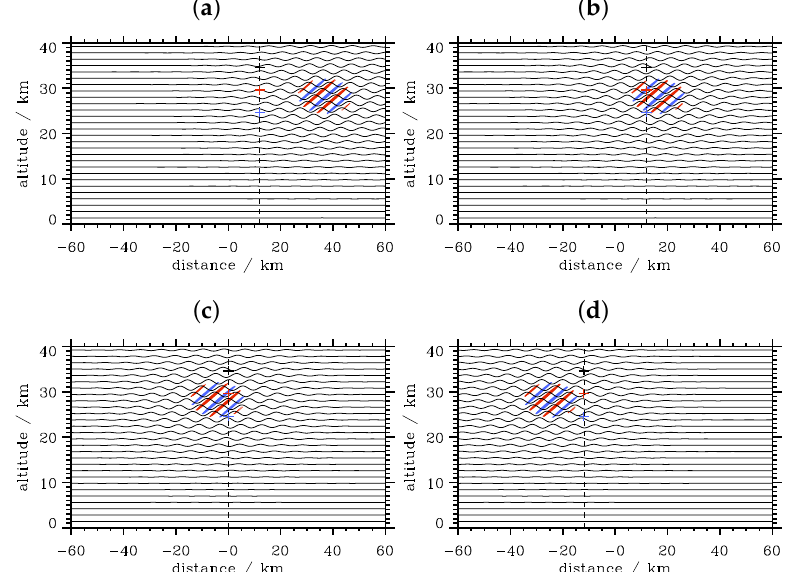
Figure 7. Spatial snapshots of the vertical displacements ξ ( x , z , t ) of horizontally- and vertically-propagating wave packets with wavenumber vectors (cid:126) k D at t = 60min. The wave frequencies are Doppler shifted by U = + c Px ( a ), U = 0 ( b ), U = − c Px ( c ) and U = − 2 c Px ( d ), respectively. Red and blue contour lines refer to ± 0.95 times the wave amplitude and illustrate phase lines. The dashed vertical black lines refer to the horizontal positions x = − 12km, 0, 12km where the vertical time series shown in Figure 8 are recorded. The blue, red, and black crosses refer to the vertical positions z = 24.6km, 29.6km and 34.6km where the time series of Figure 9 are recorded.